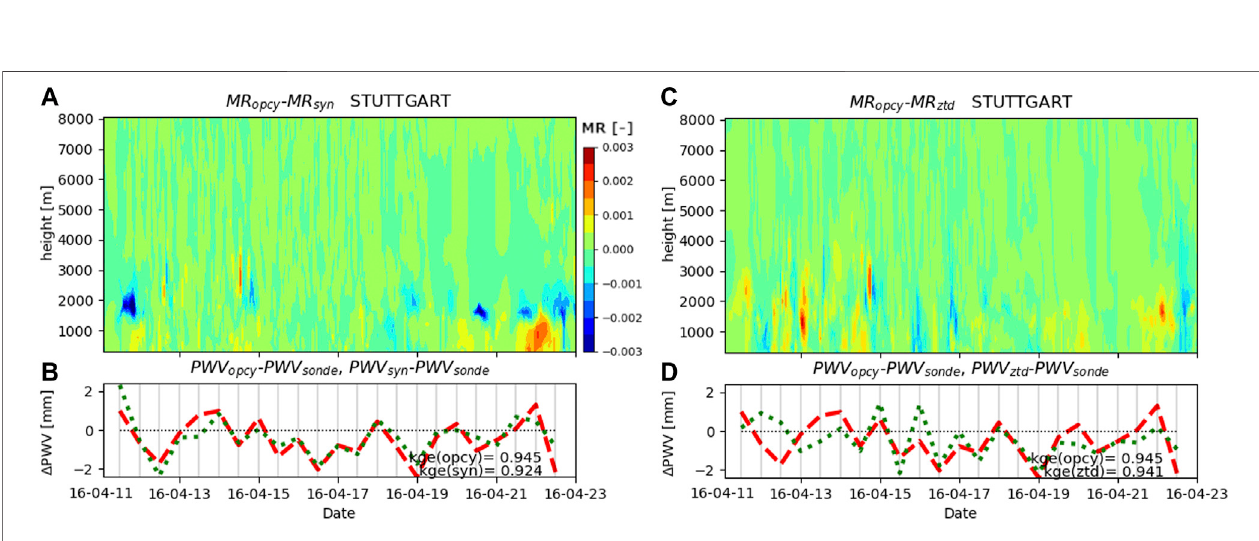
FIGURE7| Differenceofthemixingratio(MR)withheightattheStuttgartlocationforthespringepisode,comparingtheopencyclesimulation(red)withassimilating (A) synoptic data only (green) and (C) ZTD only (green) and difference of corresponding PWV values and radiosonde data (B,D) .